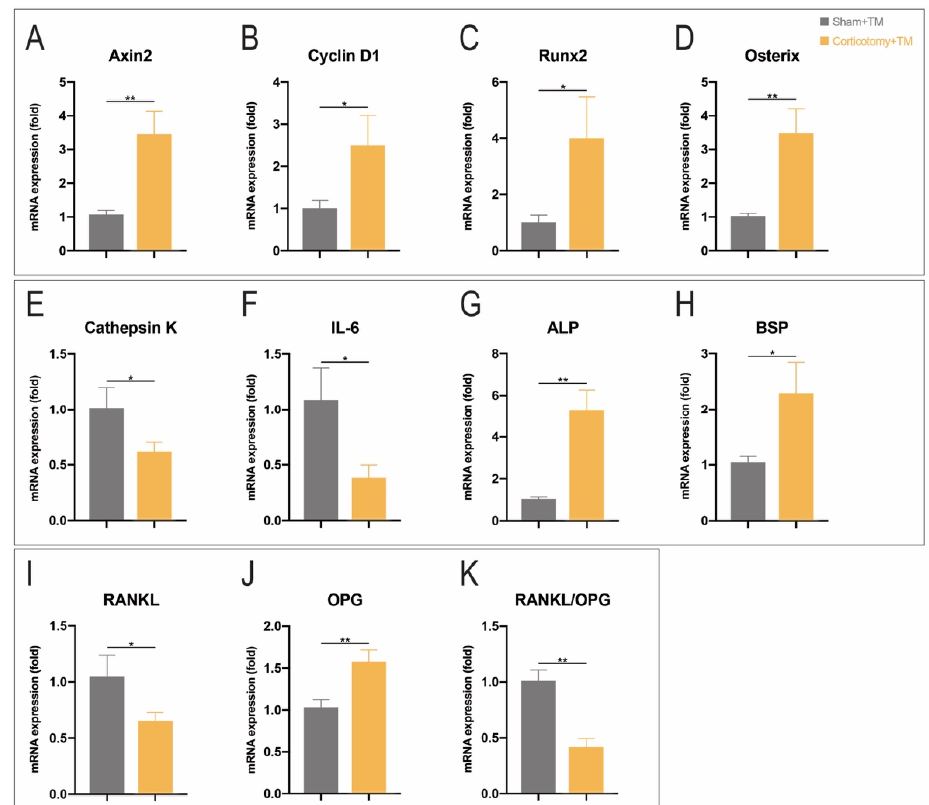
Figure 3. Quantitative real-time polymerase chain reaction of gene expression surrounding the roots of the upper first molar in the Sham + TM and Corti + TM groups ( n = 12). ( A ) Expression levels of Axin2, ( B ) Cyclin D1, ( C ) Runx2, ( D ) Osterix, ( E ) Cathepsin K, ( F ) IL-6, ( G ) ALP, ( H ) BSP, ( I ) RANKL, and ( J ) OPG. ( K ) Expression level ratio of RANKL/OPG. Abbreviations: *: p < 0.05; **: p < 0.01; ***: p < 0.001; ****: p < 0.0001.